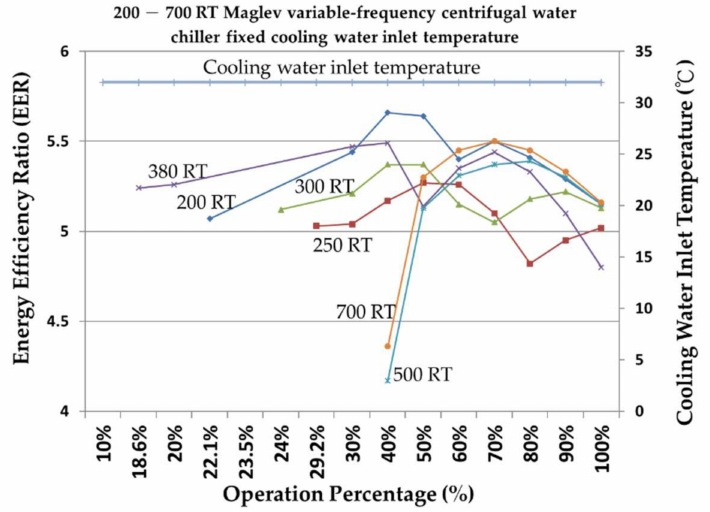
Figure 12. Fixed-cooling water inlet temperature EER of the 200–700 RT Maglev variable-frequency water